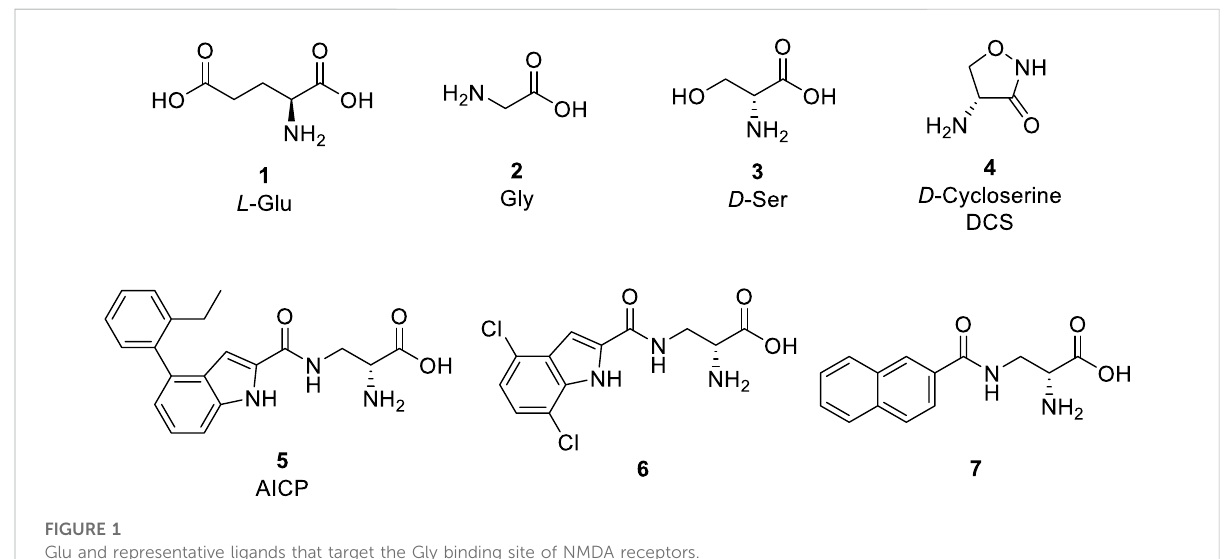
FIGURE 1 Glu and representative ligands that target the Gly binding site of NMDA